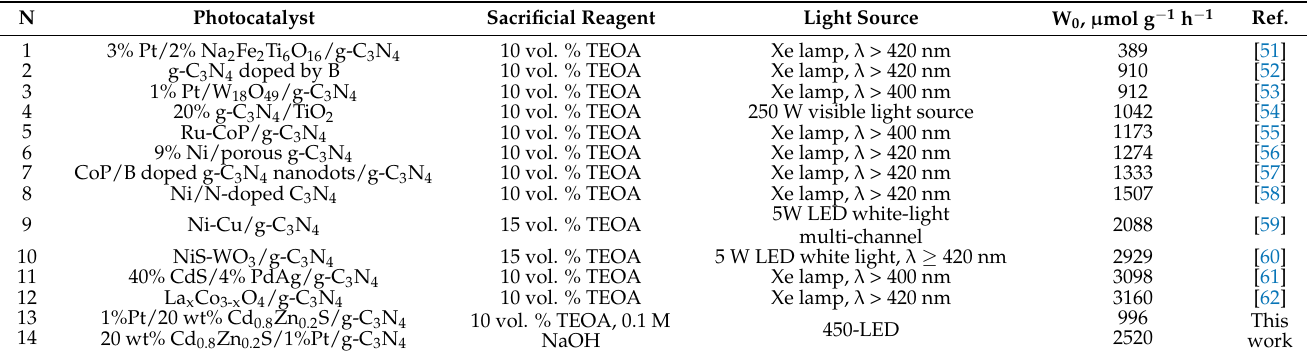
Table 4. Comparison of the results with previously published data.